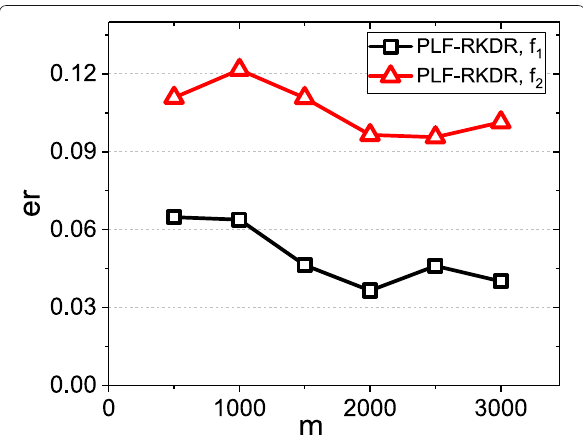
Fig. 5 The impact of m on the relative error of PLF-RKDR algorithm on the simulation